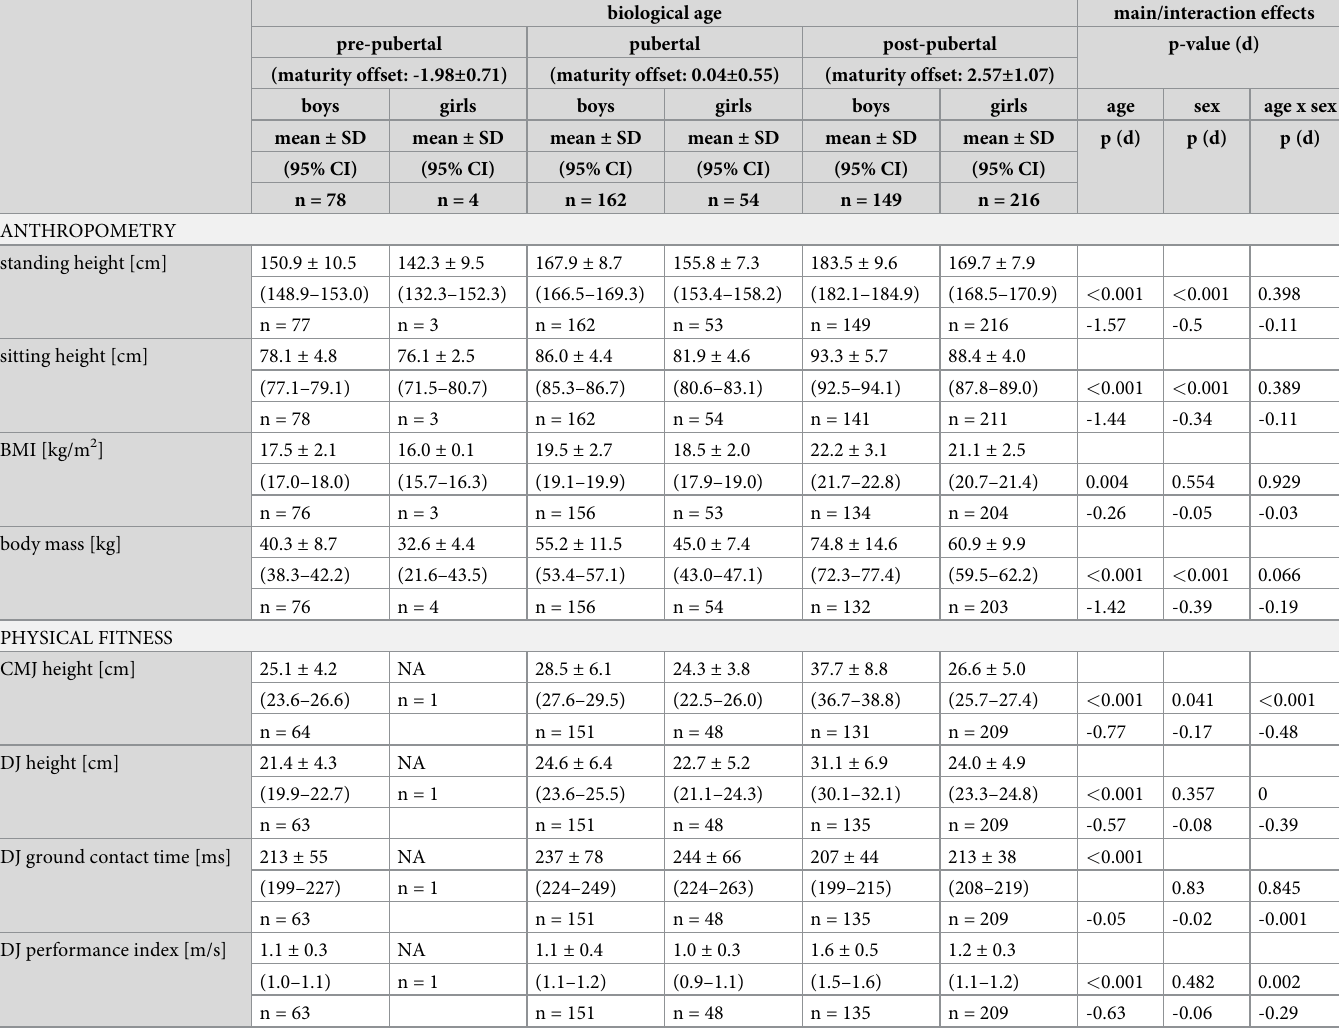
Table 2. Anthropometric and physical fitness differences according to maturity status and sex in young